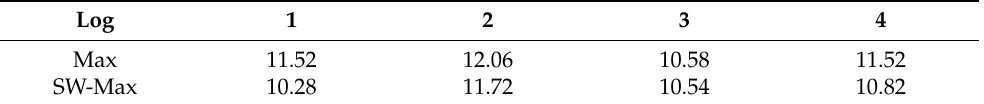
Table 4. MAE of apex spotting using log function and concatenation properties.